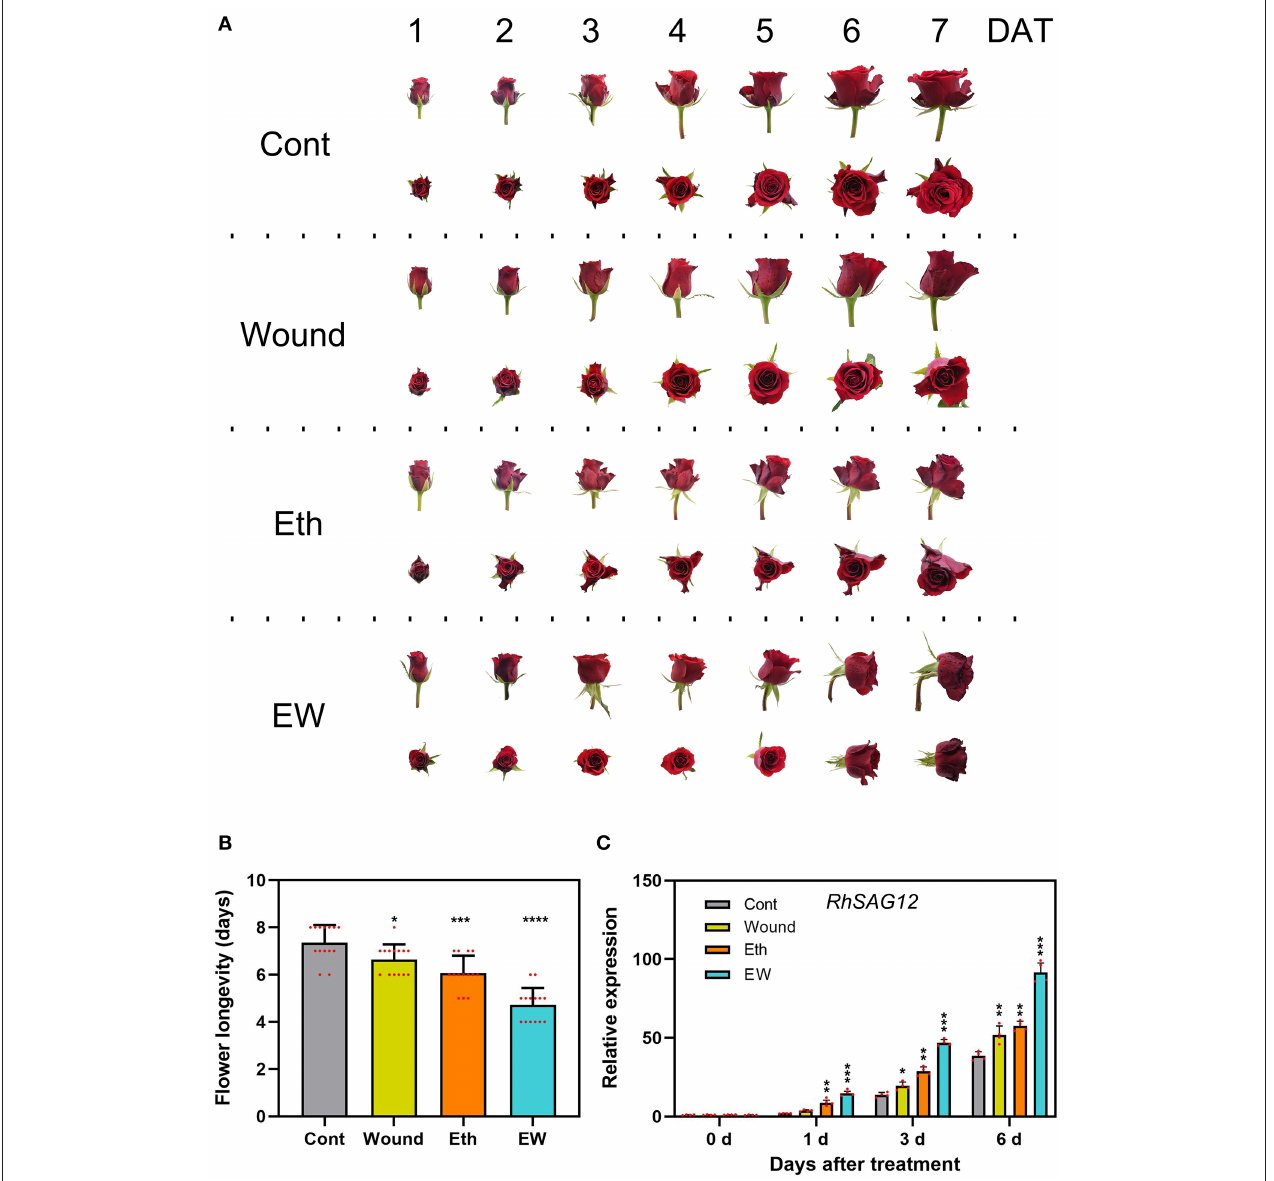
FIGURE 1 | Effects of wound and ethylene on the senescence of rose flowers. (A) The phenotypes of flowers were recorded and photographed every day after wound and ethylene treatment. (B,C) The flower longevity and relative expression of RhSAG12 by reverse transcription PCR (RT-qPCR) were determined. Values are means ± SD, RhUBI2 and RhActin5 were used as reference genes, and asterisks indicate statistically significant differences (* p < 0.05, ** p < 0.01, *** p < 0.001, Student’s t